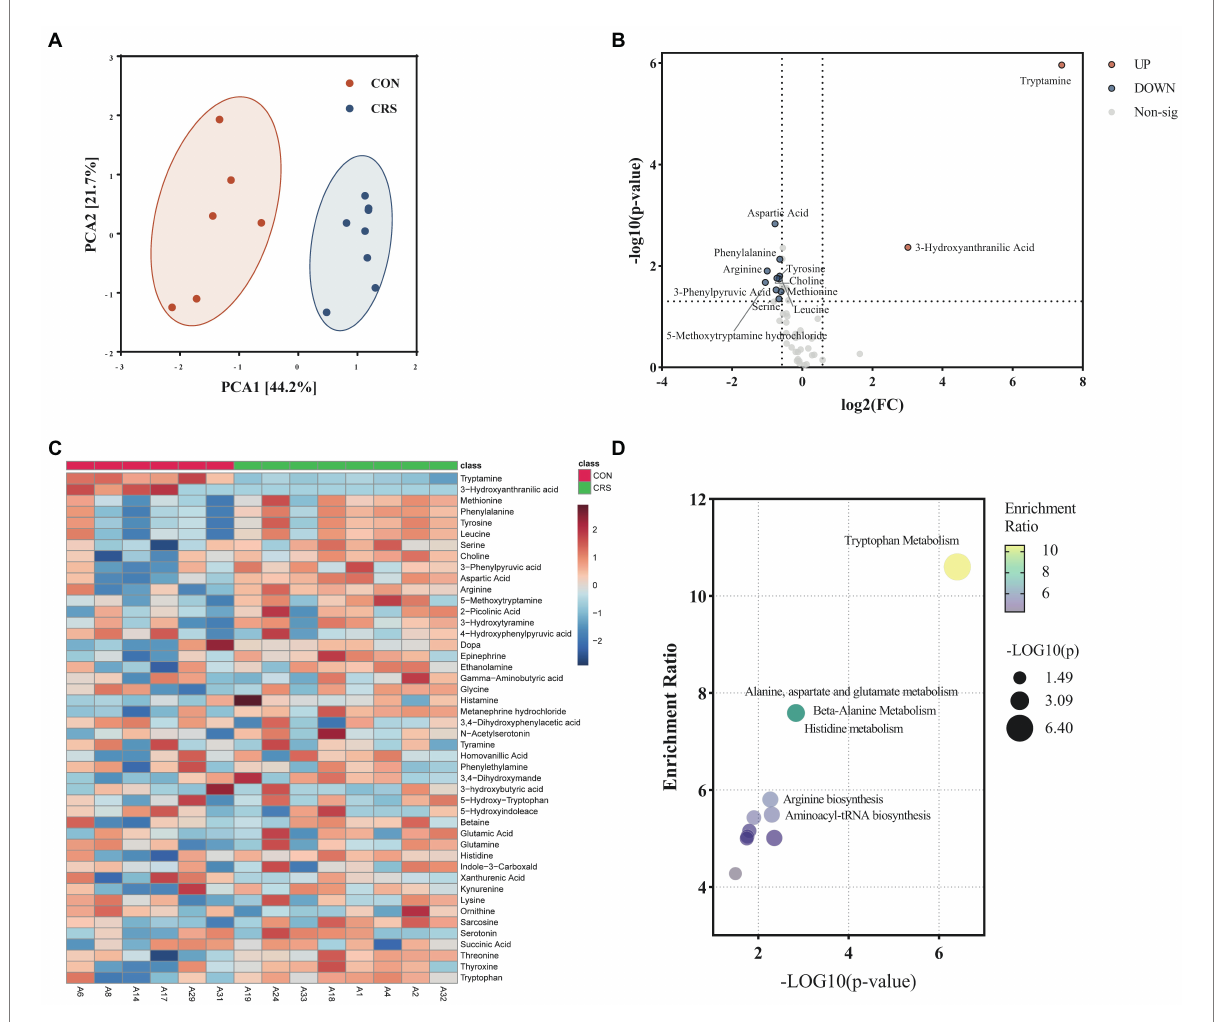
FIGURE 4 Characterization of metabolites profile of neurotransmitters from mice fecal. (A) Principal component analysis (PCA) Scores plot between the two groups. The explained variances are shown in brackets. (B) Volcano plot for differential metabolites. Significantly regulated metabolites between groups determined by fold change and value of p (FC>|1.5|, p < 0.05). Red dots represent increased metabolites in CON group; blue dots represent decreased metabolites in CON group. (C) Heatmap of all neurotransmitters; differential metabolites were indicated by an asterisk. (D) Pathway enrichment analysis of differential